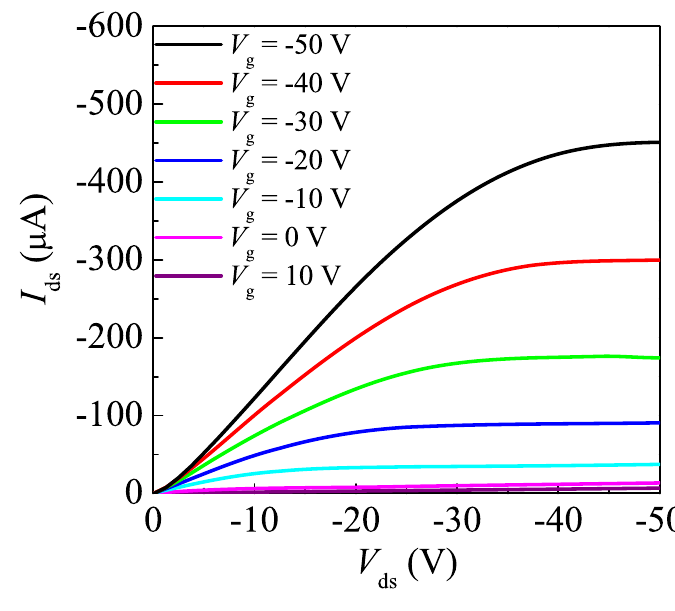
Figure 4. Typical result of field-effect transistor (FET) performance of the PAT6 layer after the SVT at 21.6 vol % concentration at 25 °C for 20